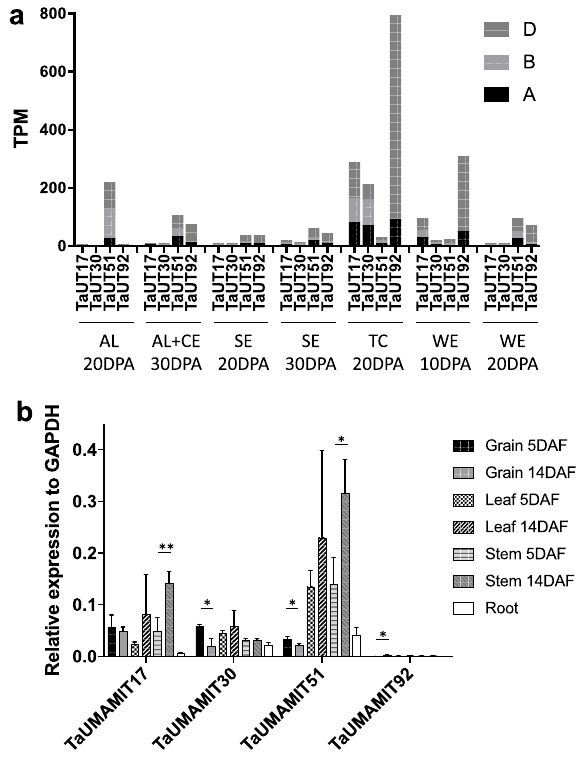
Figure 6. Expression of selected TaUMAMITs in grain tissues. ( a ) Expression of TaUMAMIT17, 30, 51, 92 in various grain tissues. The TPM values for each subgenome are indicated. AL Aleurone layer, CE Central endosperm, SE Starchy endosperm, TC Transfer cells, WE Whole endosperm, DPA Days after anthesis. ( b ) Expression of selected TaUMAMITs in developing grains, leaf, stem and root. The mRNA levels detected with RT-qPCR are expressed as the relative amount to the reference gene, TaGAPDH. Statistical difference according to Student’s t-test is indicated by asterisk ( p < 0.05). All experiments were conducted at n = 3. DAF Days after